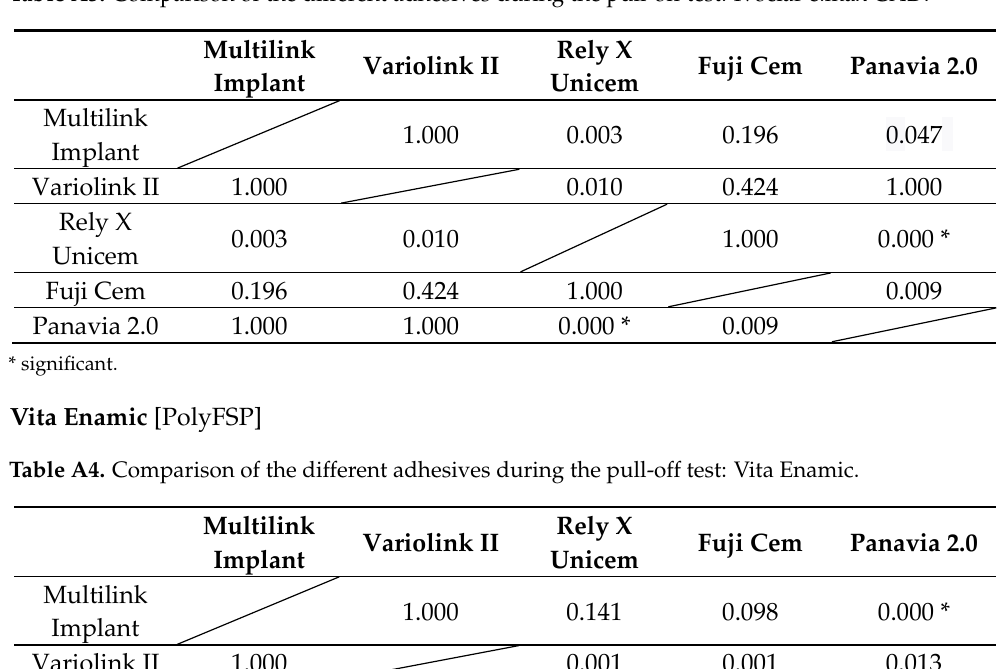
Table A3. Comparison of the different adhesives during the pull-off test: Ivoclar e.max CAD.